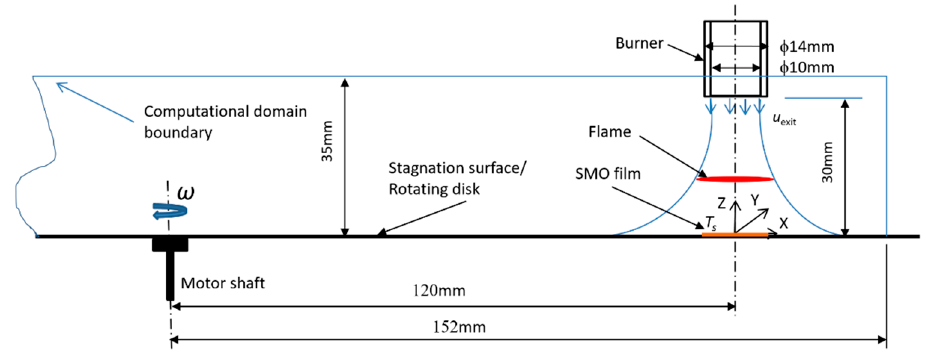
Figure 2. Schematic of the computational domain for the FSRS simulation.